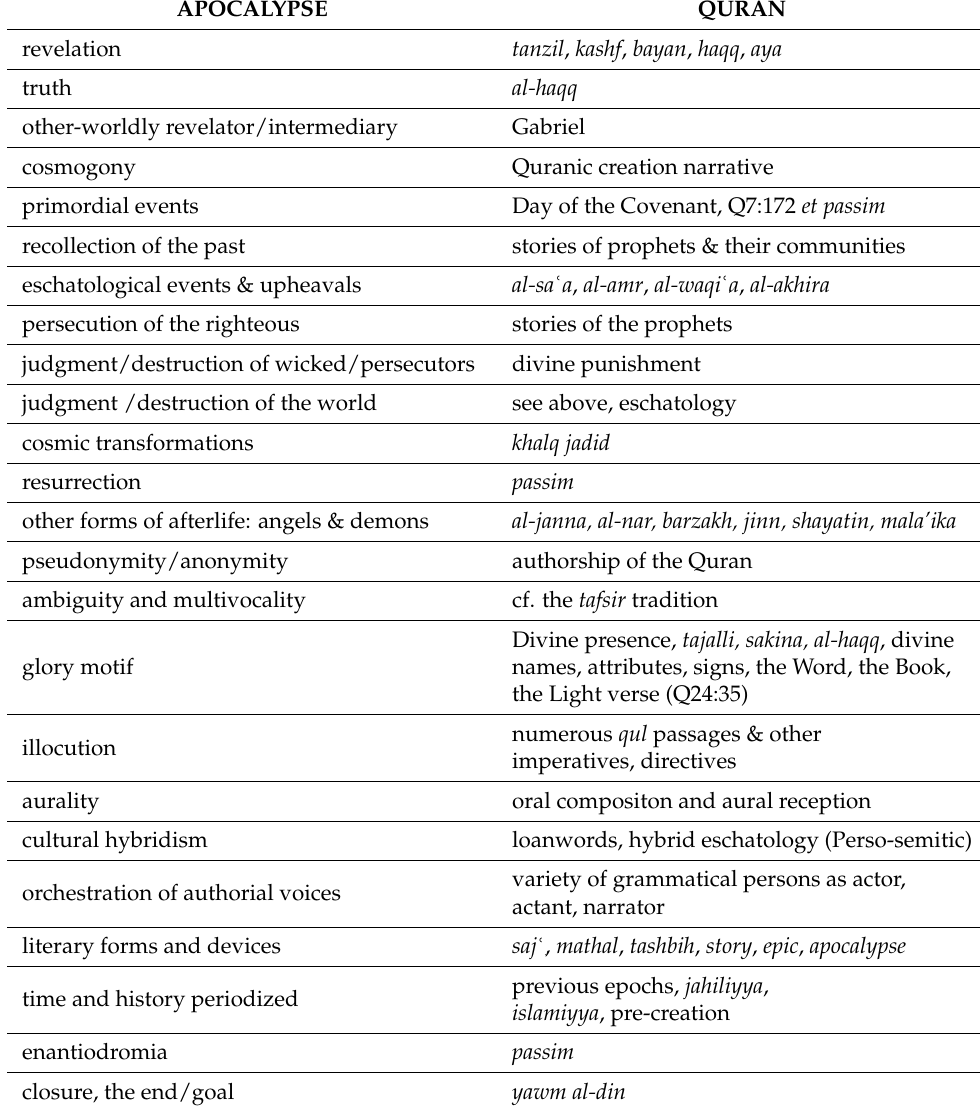
Table 1. Apocalyptic themes and motifs with Quranic